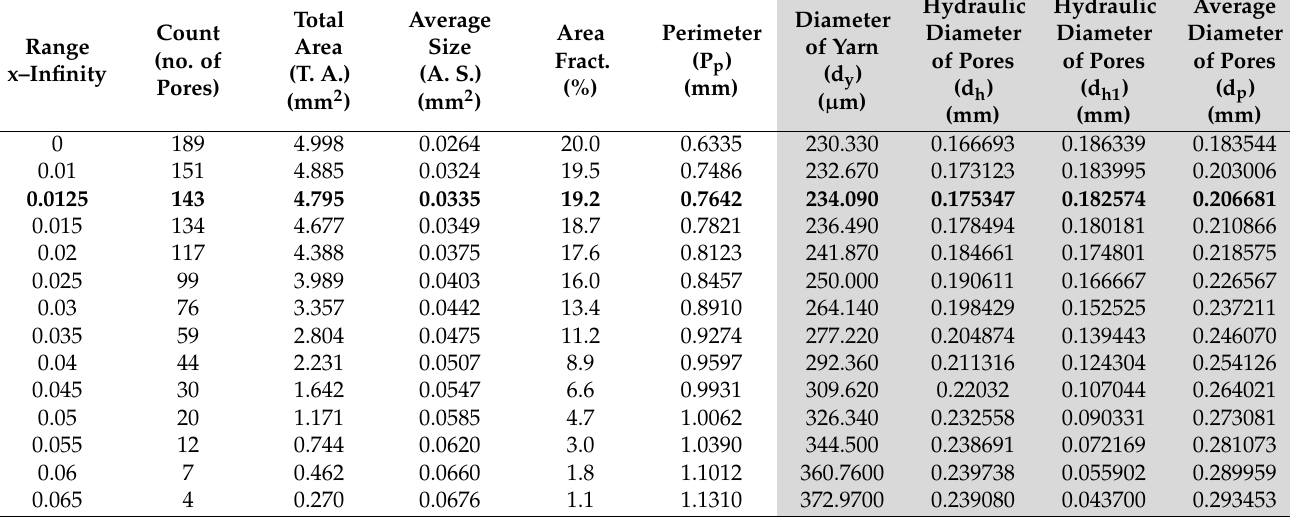
Table 1. Presentation of ImageJ processed measurement for fabric in plain